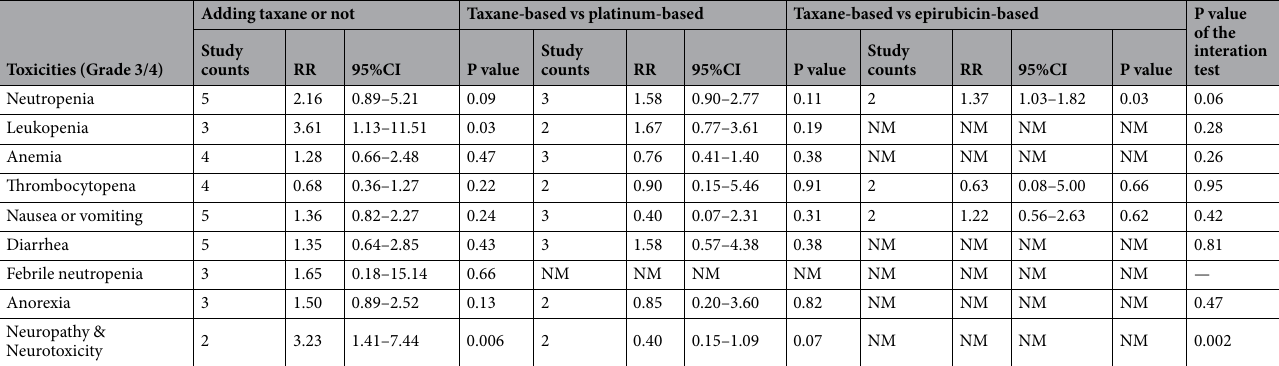
Table 3. Toxicities comparison between subgroup. NM: Not